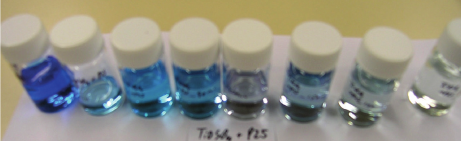
Figure 8: MB decolorization with TiOSO 4 30,6 wt%+TiO 2 -P25 catalyst.